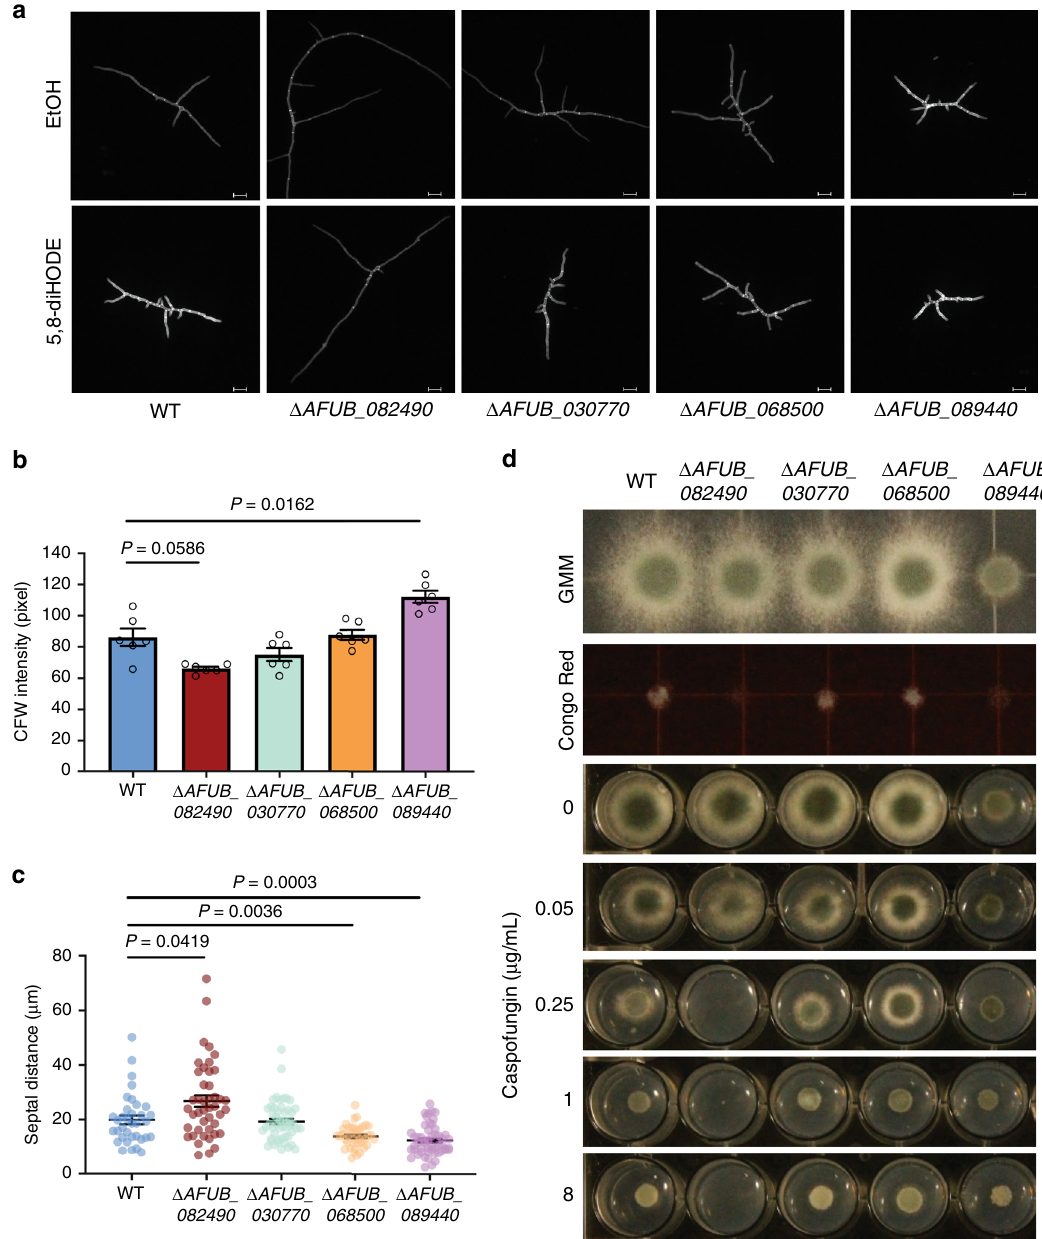
Fig. 6 5,8-diHODE-responsive transcription factor deletants display altered hyphal septation and cell wall integrity. a Representative DAPI images of A. fumigatus A1160 pyrG + WT control and deletion mutants Δ AFUB_082490, Δ AFUB_030770 , Δ AFUB_068500 , and Δ AFUB_089440 grown in GMM containing 0.1% EtOH or 5 µ g/mL 5,8-diHODE. Fourteen-hour-old hyphae grown on a coverslip in a 24-well plate were stained with calco fl uor white (CFW), washed in ddH 2 O, and mounted to slides. Six DAPI images were acquired from three wells for each condition in each strain ( n = 6). Images are representative of six microscopic images acquired for each condition. Scale bars represent 20 µ m. b Quanti fi cation of CFW signals of hyphae ( n = 6) grown in GMM + 0.1% EtOH from the six DAPI images acquired in ( a ). Hypha in each DAPI image was selected through the thresholding function in FIJI, and the mean fl uorescence intensity of each threshold area was measured. c Quanti fi cation of distances between adjacent septa in the six hyphae of each strain grown in GMM + 0.1% EtOH and imaged in the experiment performed in ( a ). Sample sizes representing the number of septal distances counted for each strain are: n = 35 for WT, n = 44 for Δ AFUB_082490 , n = 51 for Δ AFUB_030770 , n = 40 for Δ AFUB_068500 , n = 52 for Δ AFUB_089440 . d Sensitivity of A1160 pyrG + WT control and transcription factor deletion mutants to cell wall perturbation agents Congo Red (25 µ g/mL) and caspofungin at indicated concentrations. GMM was used as control. In all, 2000 spores were inoculated and grown for 2 days before the visual examination. Brown – Forsythe and Welch ANOVA tests were performed, followed by Dunnett ’ s T3 multiple comparison test between mutant strains and the WT control in ( b , c ). All values represent mean ±